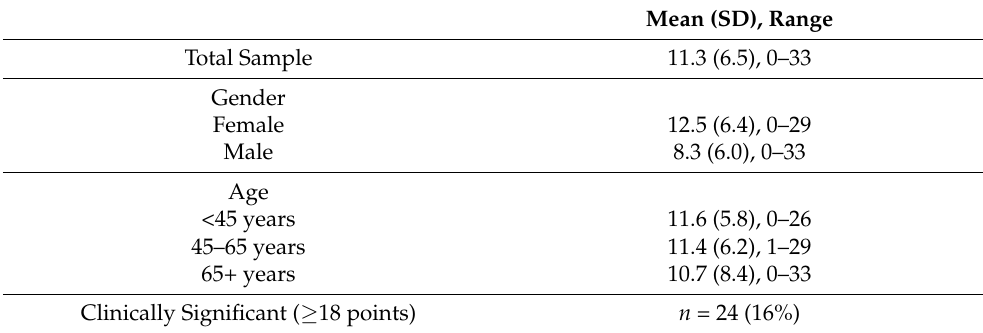
Table 2. Distribution of 14-item Short-Health-Anxiety-Inventory scores.